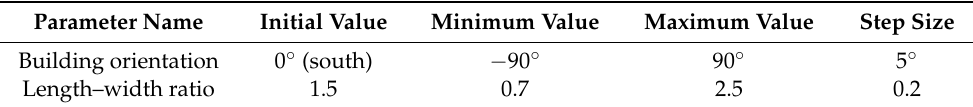
Table 2. Parameters settings for building orientation and length–width